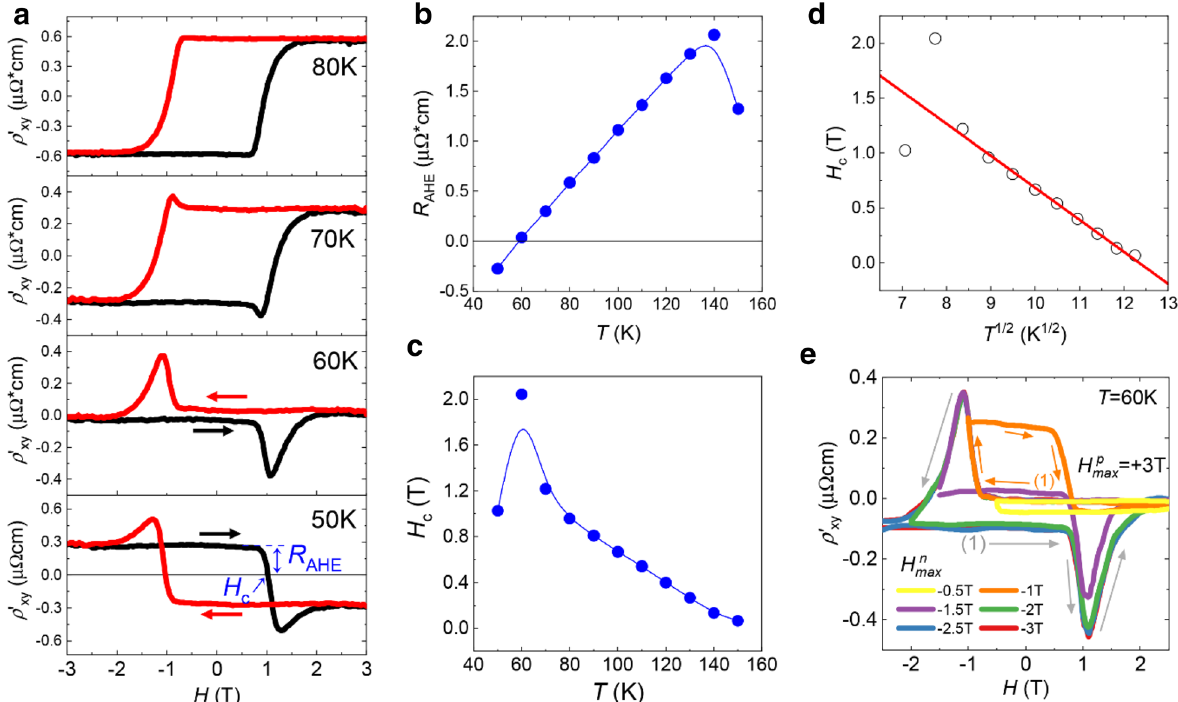
Fig. 3 Analysis of the hump structure in the CT/BSTS heterostructure. a The reduced Hall resistivity trace ( ρ ′ xy ( H ) = ρ AHE + ρ hump ) of the CT/BSTS heterostructure at temperatures of 50, 60, 70, and 80 K. b, c The amplitude of anomalous Hall resistivity, R AHE ( b ) and the coercive field, H c ( c ) as a function of temperature. The definitions of R AHE and H c are shown in panel a . d The Kneller’s plot of H c vs. T 1 / 2 . e The minor‑loop measurement at 60 K with increasing H n max 0.5 – 3 T and H p max 3 = − − =